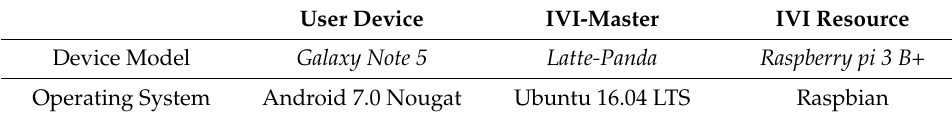
Figure 14. Testbed configuration. Table 3. Specification of the testbed.